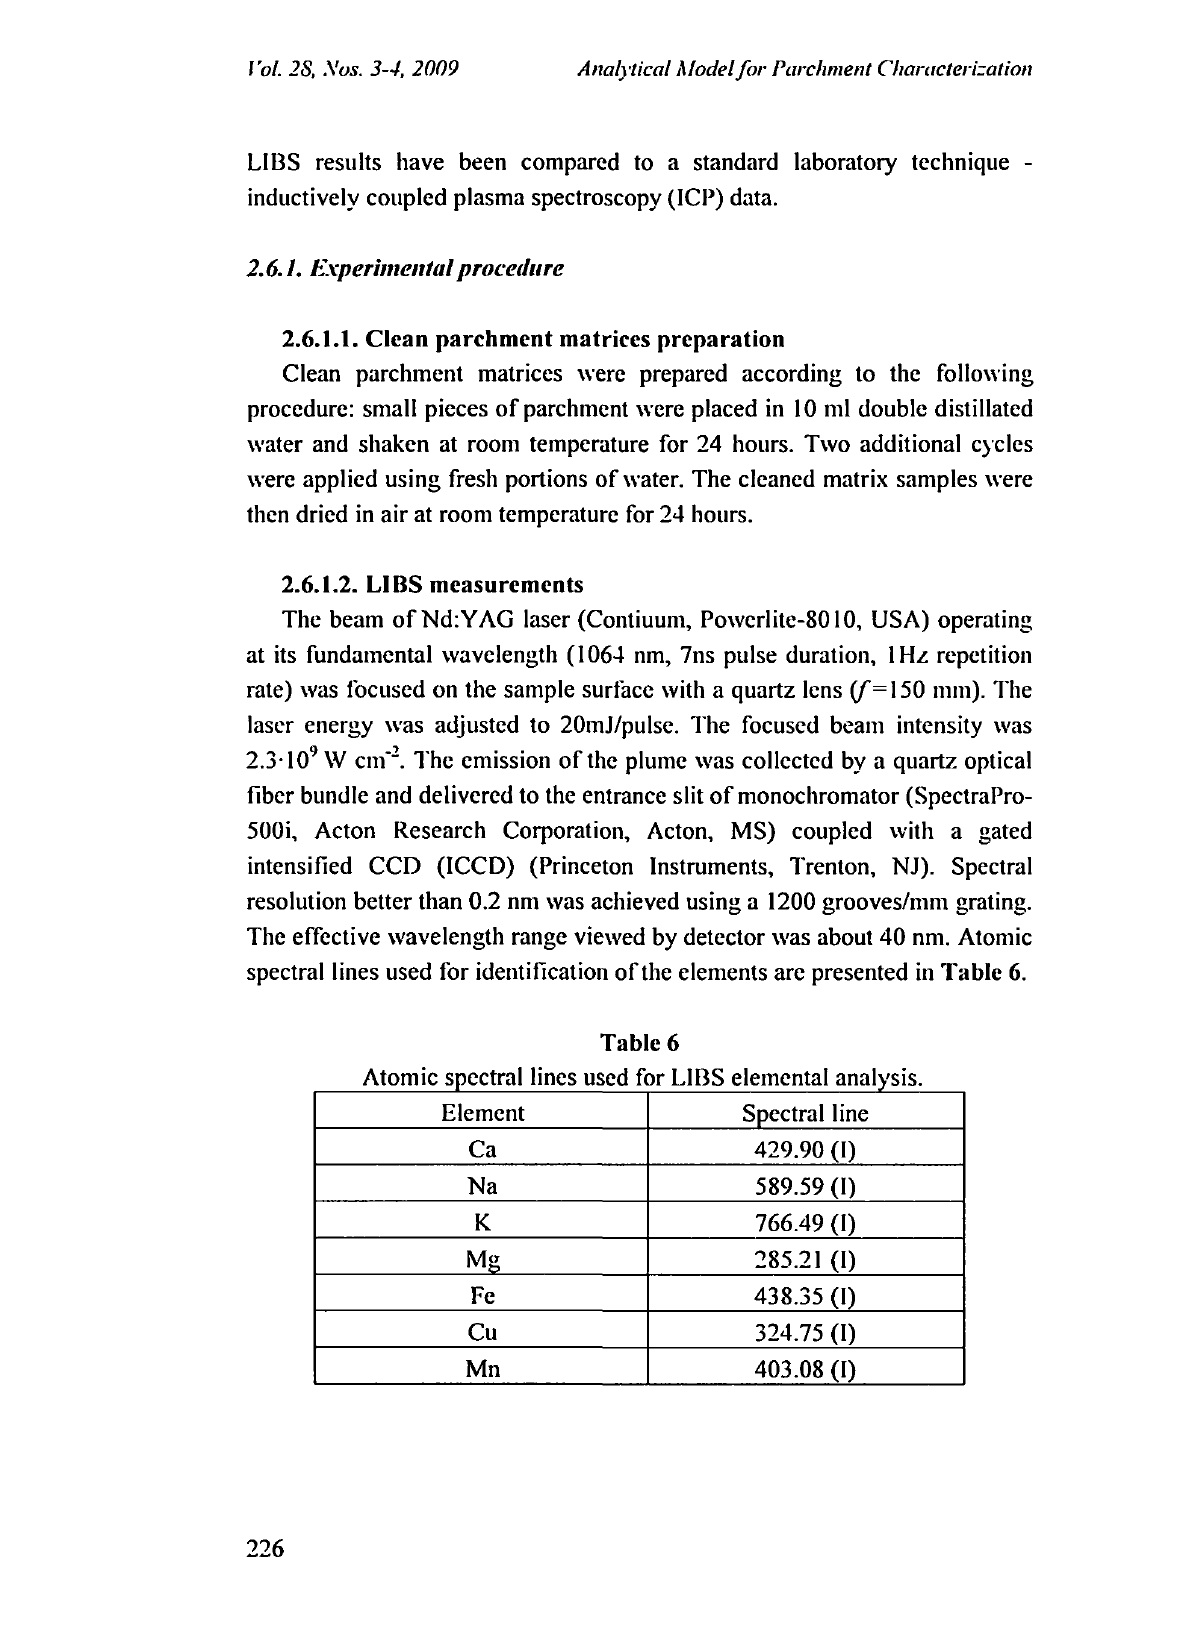
Atomic spectral lines used for LIBS elemental